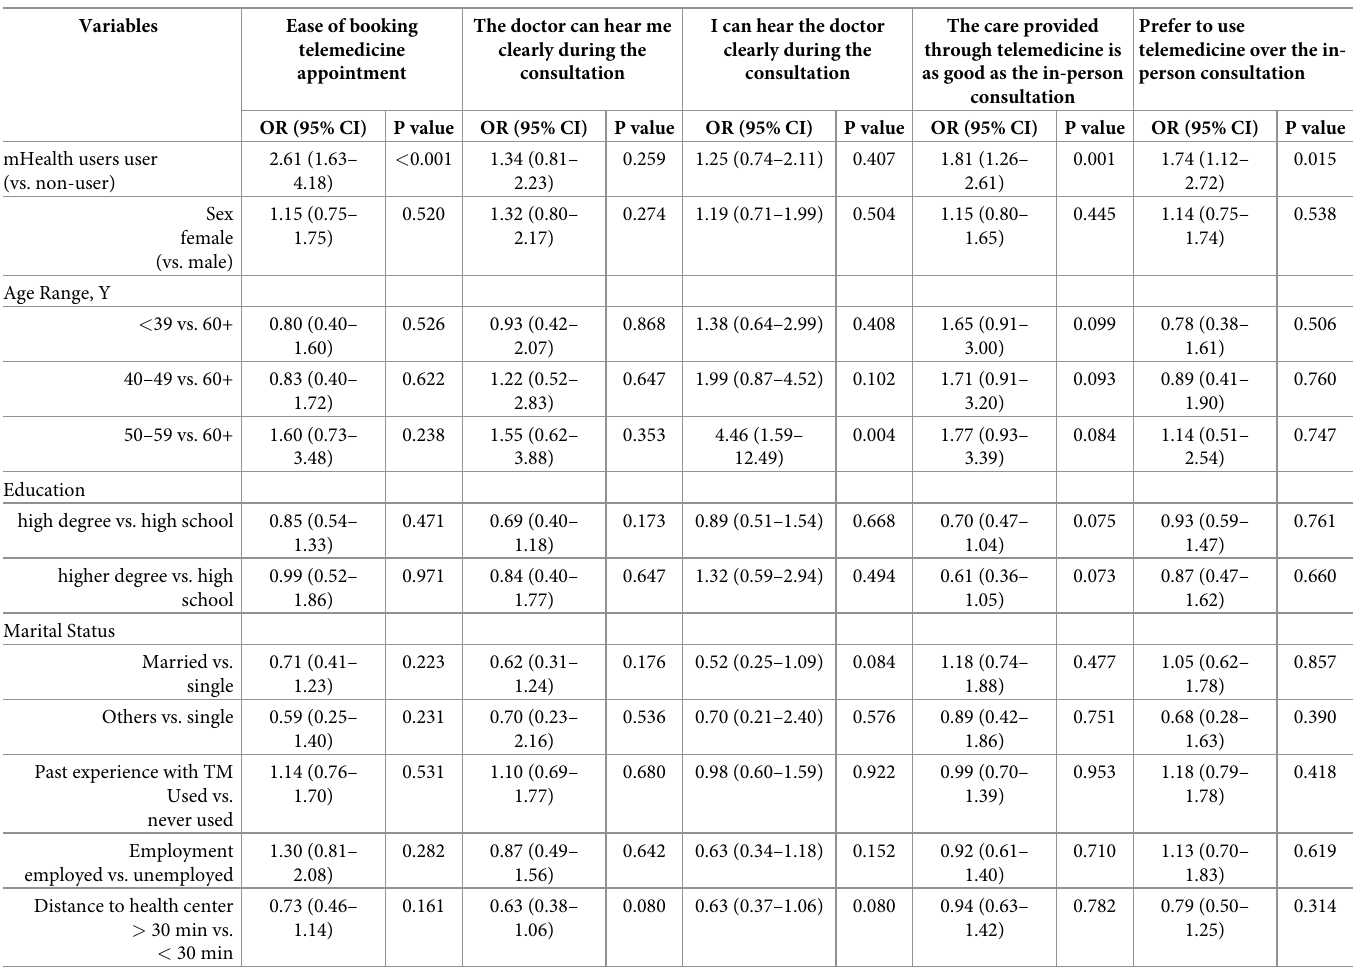
Table 3. Adjusted multivariate models for satisfaction with the telemedicine